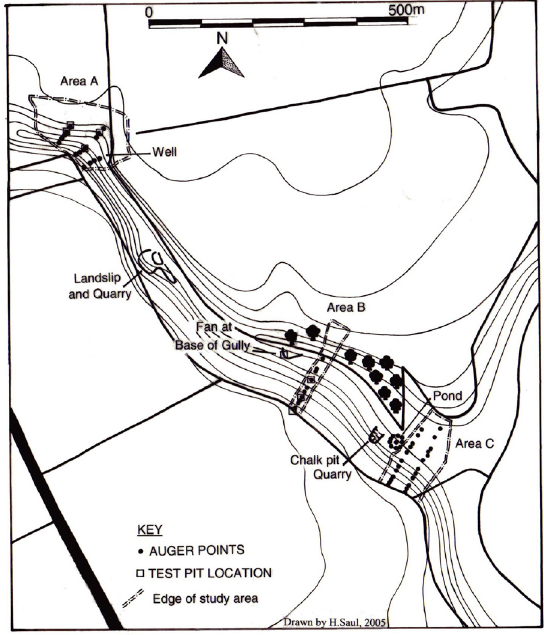
Figure 2. Interventions at Cowlam Well Dale. Image courtesy of Hayley